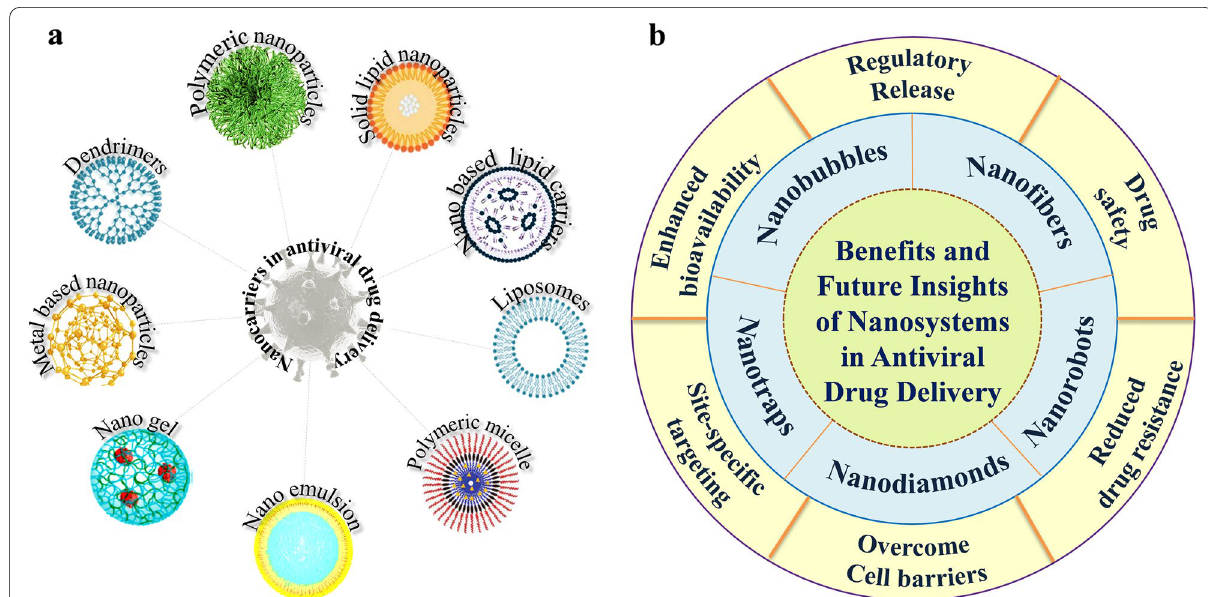
Fig. 10 a Typical nanocarriers based on solid lipid-, polymeric-, dendrimers-, metal-, nanogels, nanoemulsions, polymeric micelle-, liposomes and lipid carriers nanoparticles utility in antiviral drug delivery; b Benefits of nano systems such as drug safety, reduced drug resistance, overcome cell barriers, site specific targeting, improved bioavailability and regulatory release and moreover future perspectives of nanosystems in drug delivery including nanofibers, nanorobots, nanodiamonds, nanotraps and nanobubbles are